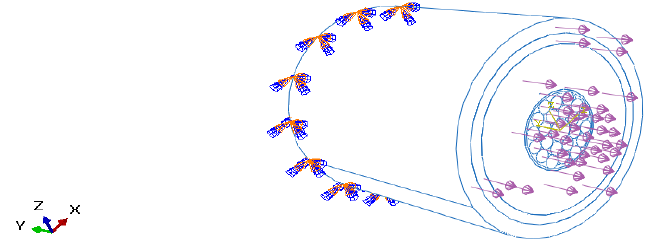
Figure 3. Pure tensile loading